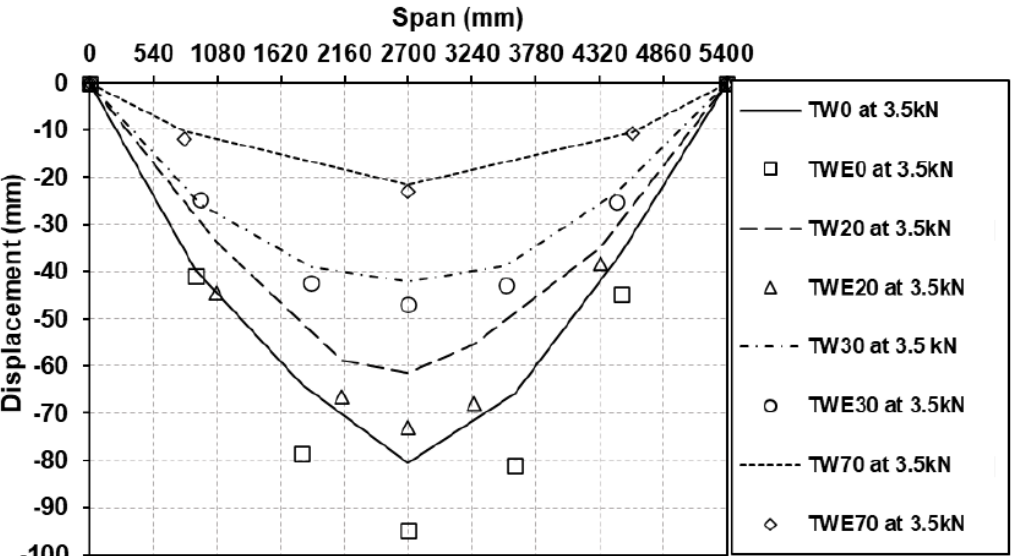
Figure 7. Deformed shapes for TWE specimens in comparison with TW specimens without envi- ronmental exposure from [45,46] at 3.5 kN with a span length of 5.4 m.